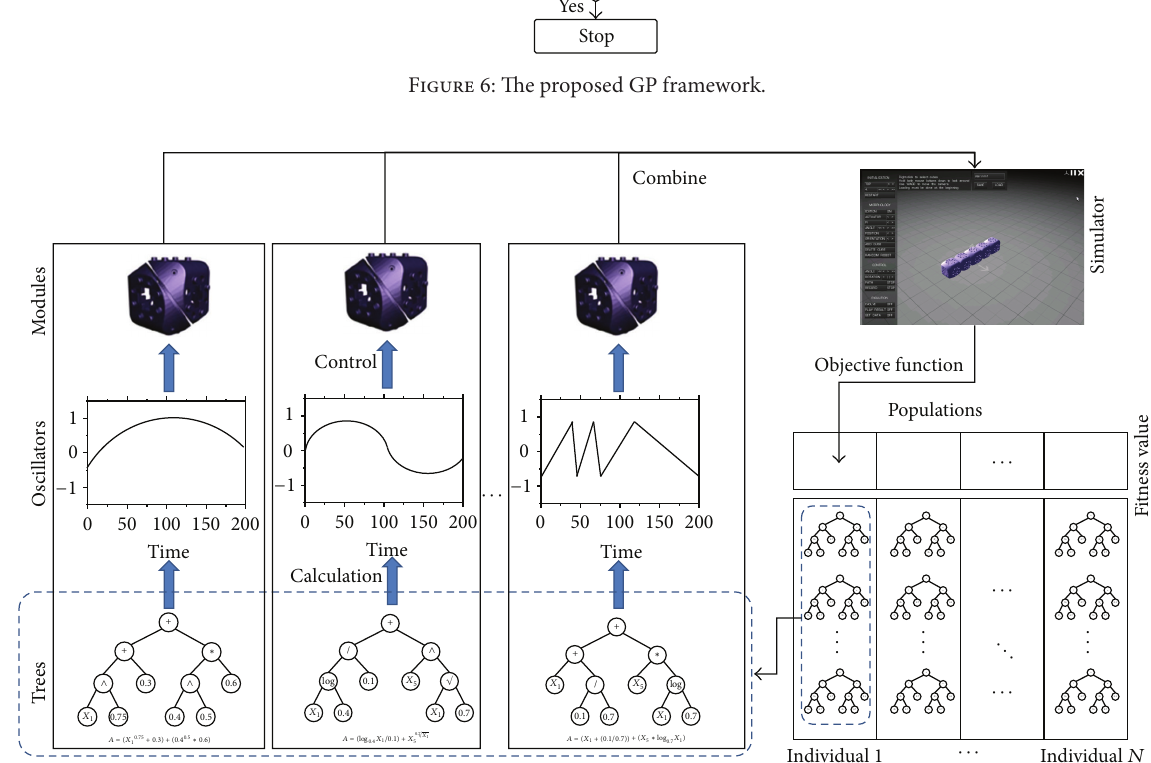
Figure 7: A description of applying the multitree GP to multiple